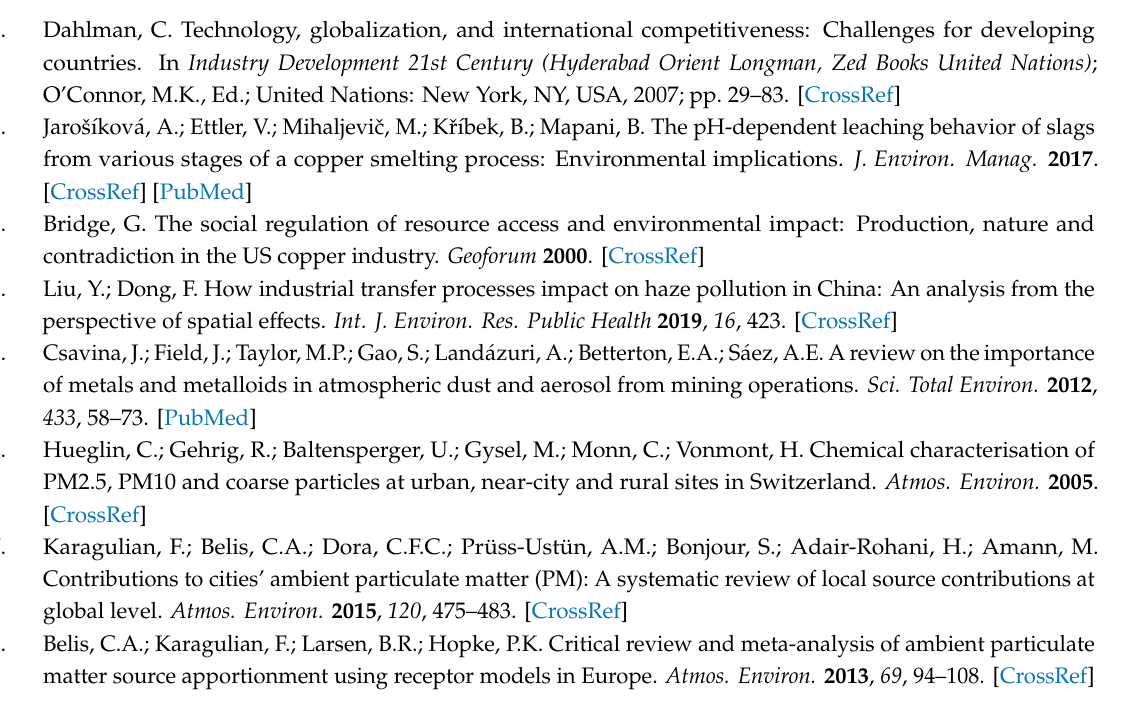
Table S1: Mineralogical phases of atmospheric particles deposited on Populus nigra Italica leaves gathered in August 2018 in the vicinity of Olmaliq city (Uzbekistan). Table S2: Percentage contribution (calculated according to Equation (1)) of mineralogical phases of atmospheric particles deposited on Populus nigra Italica leaves gathered in August 2018 in the vicinity of Olmaliq city (Uzbekistan). Percentage contribution of inorganic anthropogenic particles calculated according Equation (2). Table S3: Amount and percentage contribution (calculated according to Equation (1)) of mineralogical phases of grains in soil samples gathered in August 2018 in the vicinity of Olmaliq city (Uzbekistan). Percentage contribution of inorganic anthropogenic grains calculated according Equation (2). Table S4: Metal concentrations in soil samples gathered in August 2018 in the vicinity of Olmaliq city (Uzbekistan). Table S5: Metal concentrations in soil samples gathered in August 2018 in the vicinity of Olmaliq city